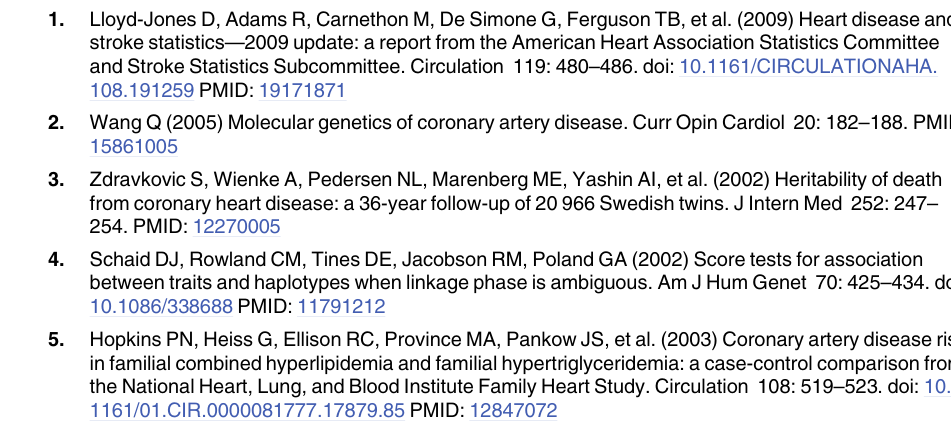
S1 Table. Details of normalizedexpression value of CETP mRNA with genotype